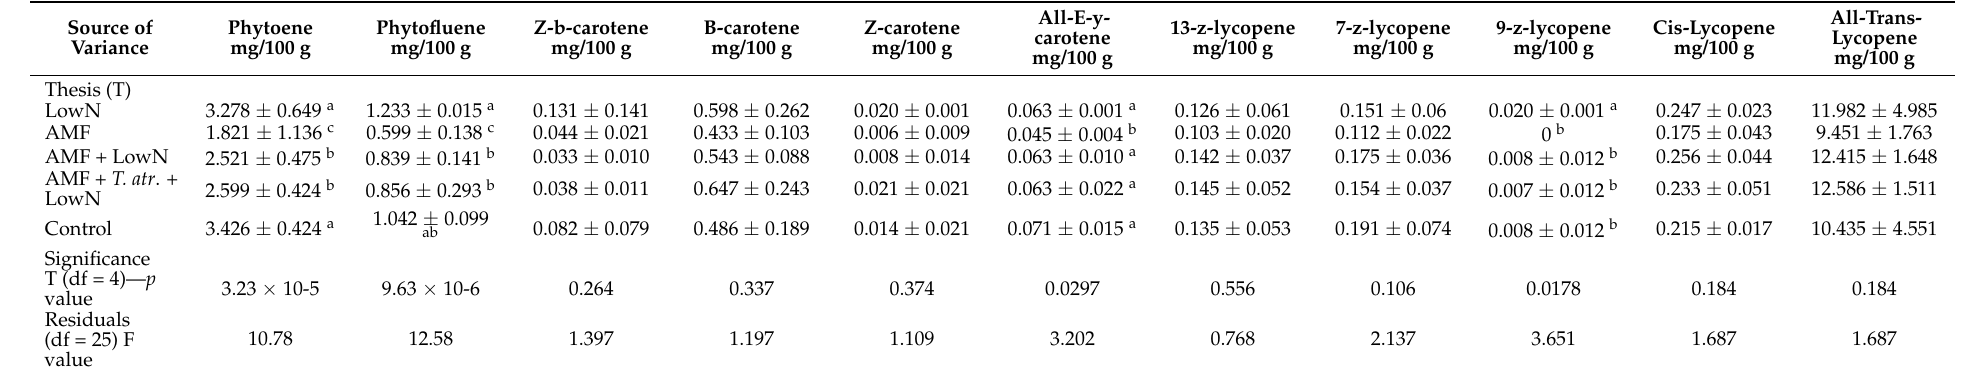
Table 3. Carotenoid content in tomato fruits from plants grown under low nitrogen fertilization regimen, treated with different biostimulants at the site with sub-optimal soil fertility. The data were elaborated by one-way analysis and Duncan test.